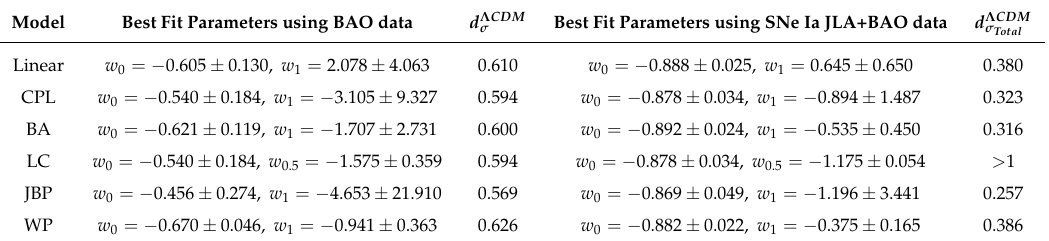
Table 2. Dark energy parameterizations with best fits and σ -distances values using BAO and the combining